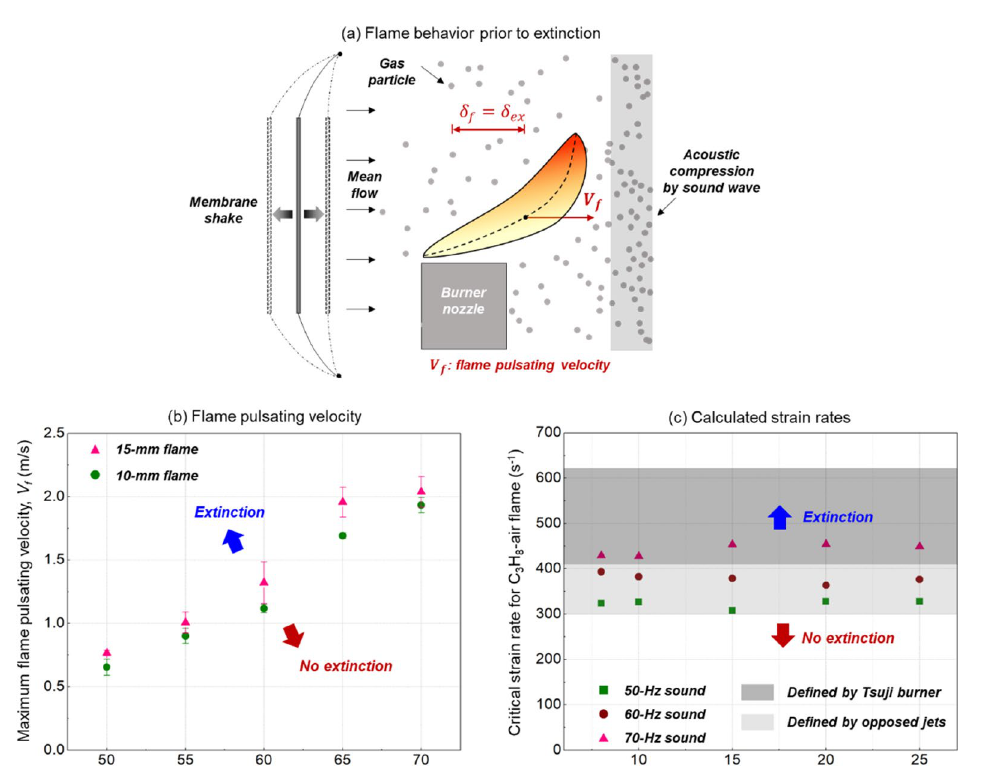
Figure 5. ( a ) Illustration of the near-limit flame shape, ( b ) the maximum flame pulsating velocity, and ( c ) critical strain rates at the extinction